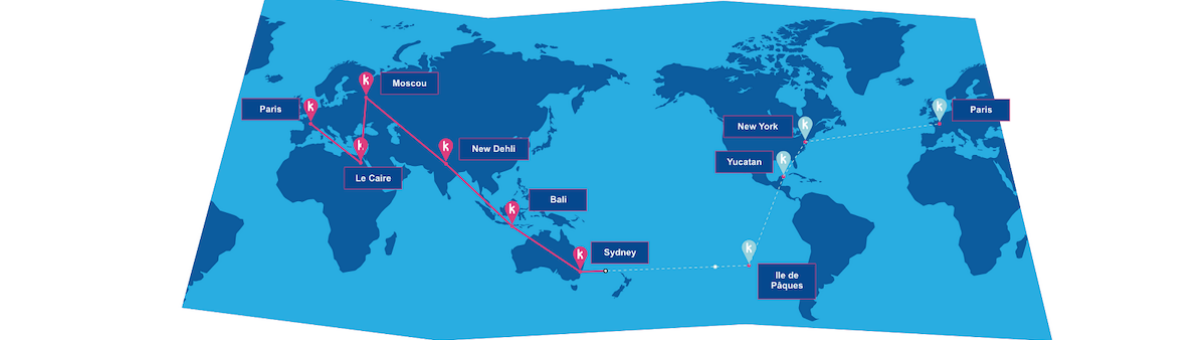
Figure 2. Activity tab (Kiplin’s activity tab